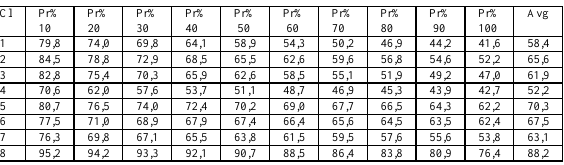
Table 3. Average precision values for each category after pre- analysis stage and labelling.